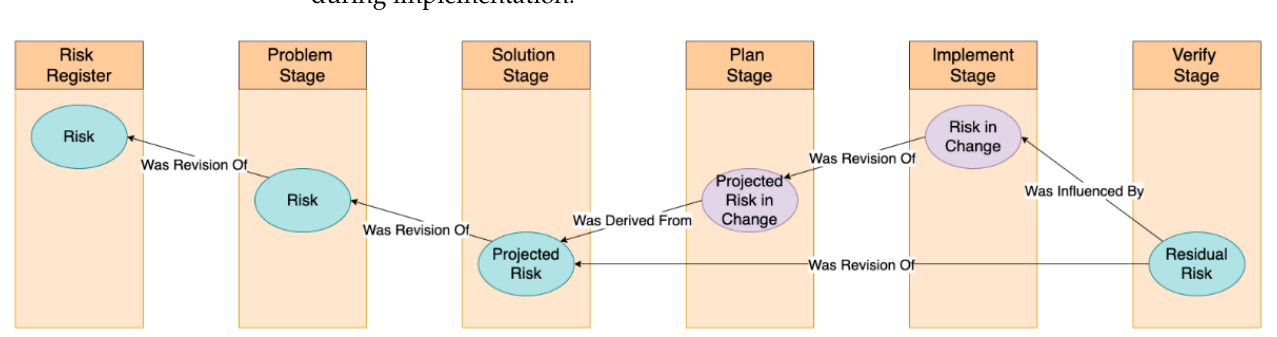
Figure 2 . Transformation of Risk through project stages in the ARK Platform. Figure 2. Transformation of Risk through project stages in the ARK Platform.